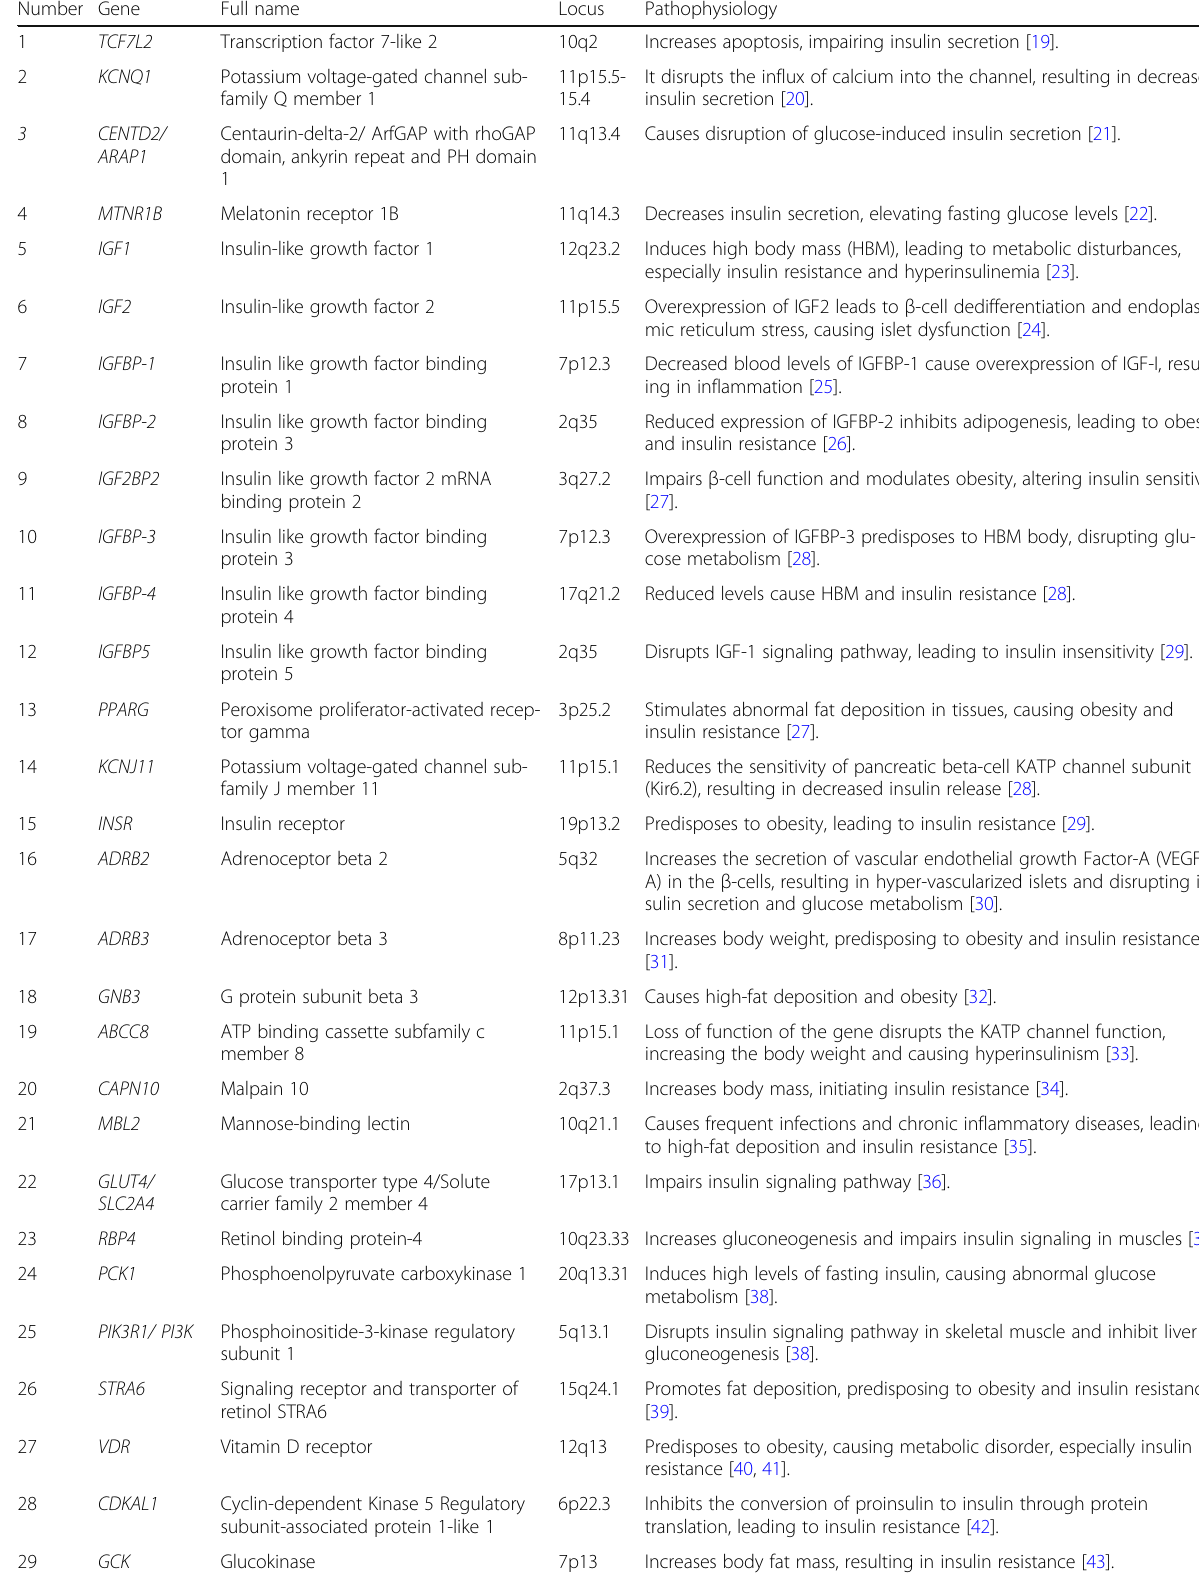
Table 1 GDM predisposing genes showing locations and